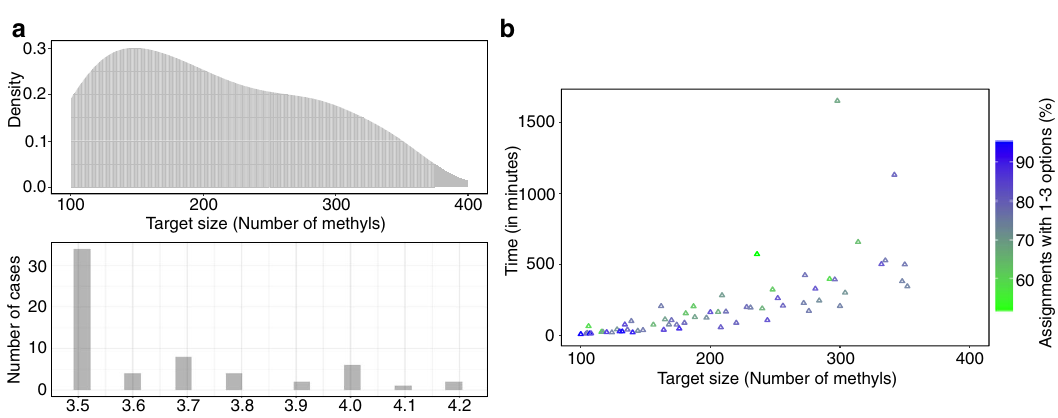
Fig. 3 Performance of MAUS on simulated ILV data graphs from larger proteins. a Top: target size distribution (in terms of number of methyl groups from Ile, Leu, and Val residues) of 63 proteins with high-resolution PDB structures of sizes up to 116 kDa (352 methyls; PDB ID: 5WTI) (top). For each target, a data graph H was simulated by removing edges from the corresponding structure graph G (de fi ned as all methyl connectivities up to 10 Å present in the 3D structure) until a degree connectivity (de fi ned as 2 × number of edges/number of nodes) in the range of 3.5 – 4.2 was reached, corresponding to 1.75 – 2.1 simulated NOEs/methyl. Bottom: bar plot showing the distribution of degree connectivities among all simulated data graphs. b Scatter plot showing run time (in minutes) taken by MAUS to perform exhaustive enumeration of the possible methyl assignment options for each H into G mapping case. Colors indicate % of methyls with up to three assignment options, according to the scale on the